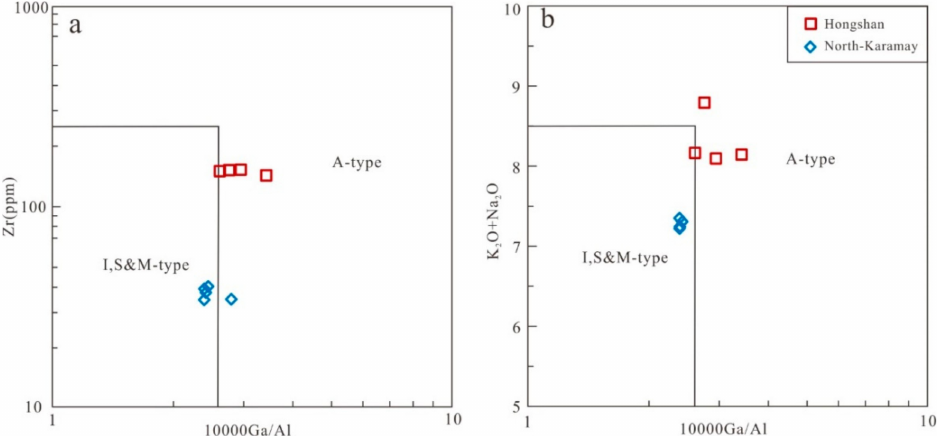
Figure 12. Trace element discrimination diagrams of the studied granitoids for rock classification: ( a ) 10000Ga / Al vs. Zr and ( b ) 10000Ga / Al vs. (K 2 O + Na 2 O) diagrams [101].